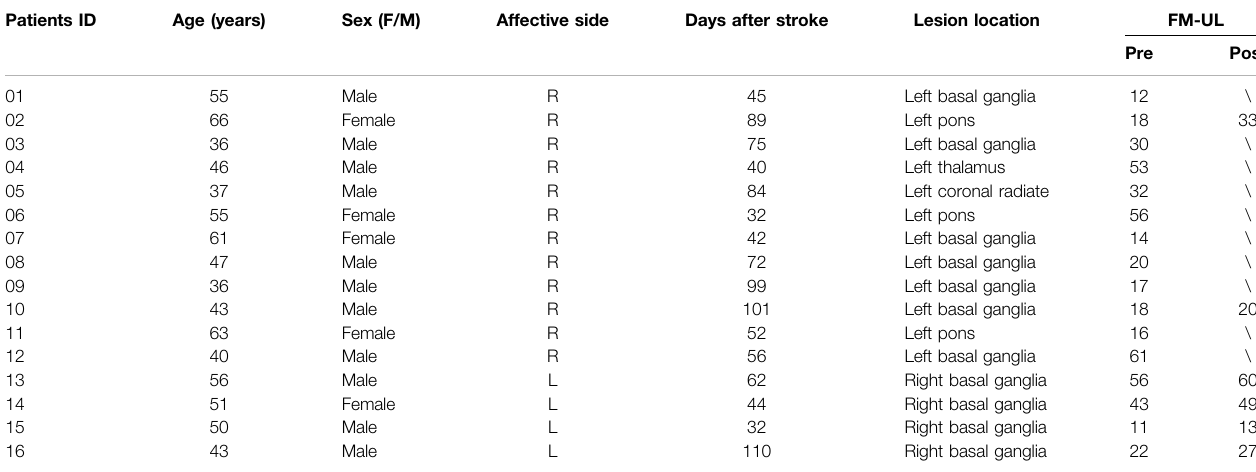
TABLE 1 | Participants demographics and clinical characteristics. Patients